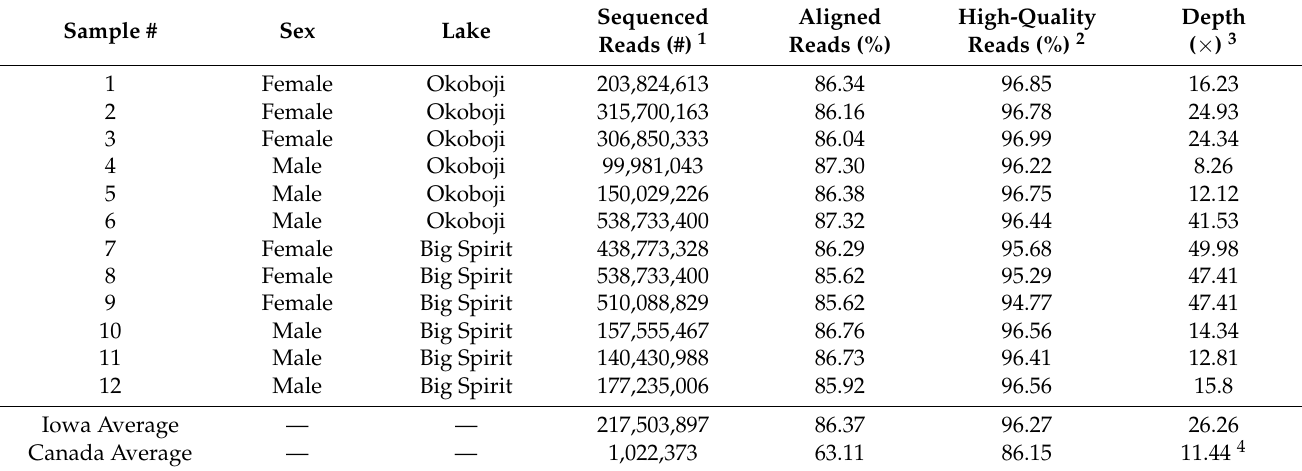
Table 1. Depth of coverage for raw whole-genome sequence data for Iowa samples.